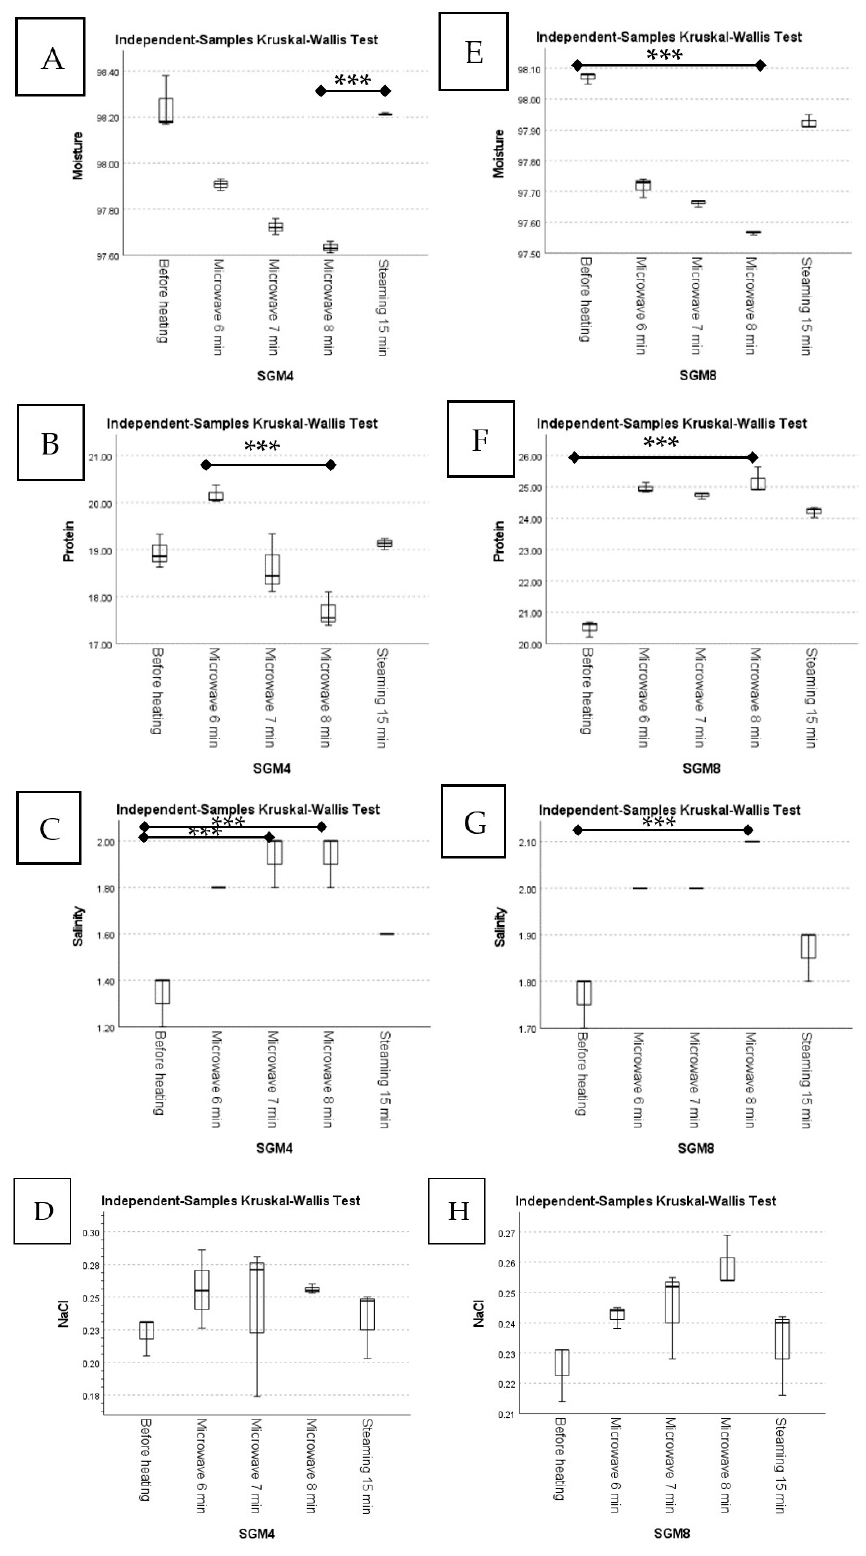
Figure 8. Boxplots of contents of ( A ) moisture, ( B ) protein, ( C ) salinity, and ( D ) sodium chloride of SGM4 before and after heat treatments and boxplots of contents of ( E ) moisture, ( F ) protein, ( G ) salinity, and ( H ) sodium chloride of SGM8 before and after heat treatments. *** between pairs indicate significantly different, according to Kruskal–Wallis and Dunn–Bonferroni tests ( p ≤